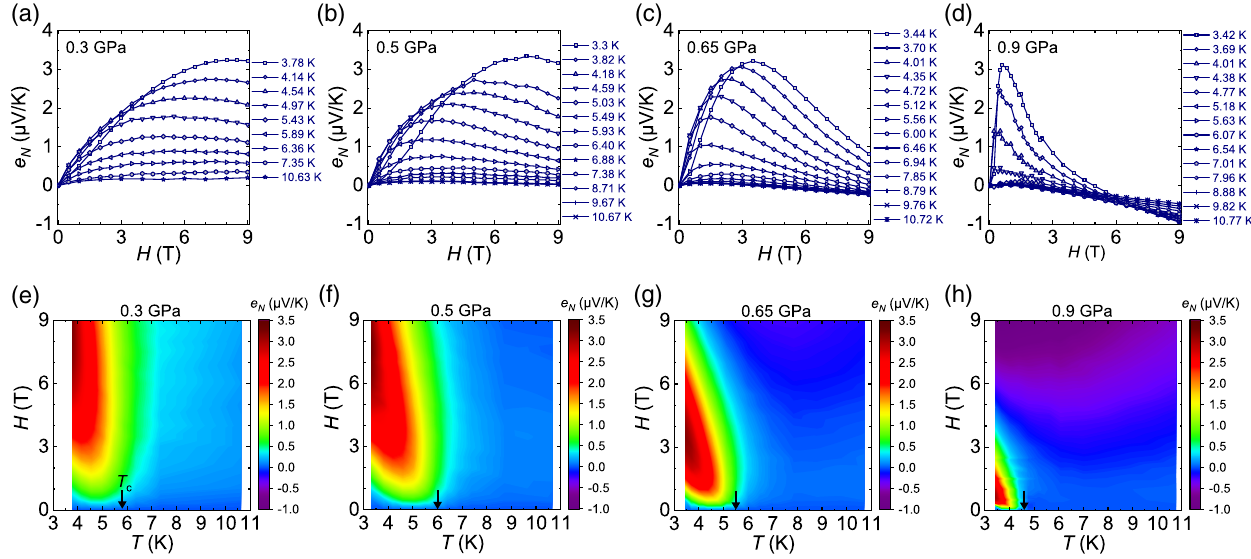
FIG. 7. Magnetic-field – temperature profile of the Nernst signal e N under different pressures. (a) – (d) Nernst signal e N traced upon sweeping the perpendicular magnetic field at several fixed temperatures under the pressures studied: 0.3, 0.5 0.65, and 0.9 GPa. (e) – (h) Contour plots of the Nernst signal e N in the temperature – magnetic-field plane at the pressures of 0.3, 0.5 0.65, and 0.9 GPa. The red areas indicate hot Nernst regions. The arrows indicate the zero-field T c .